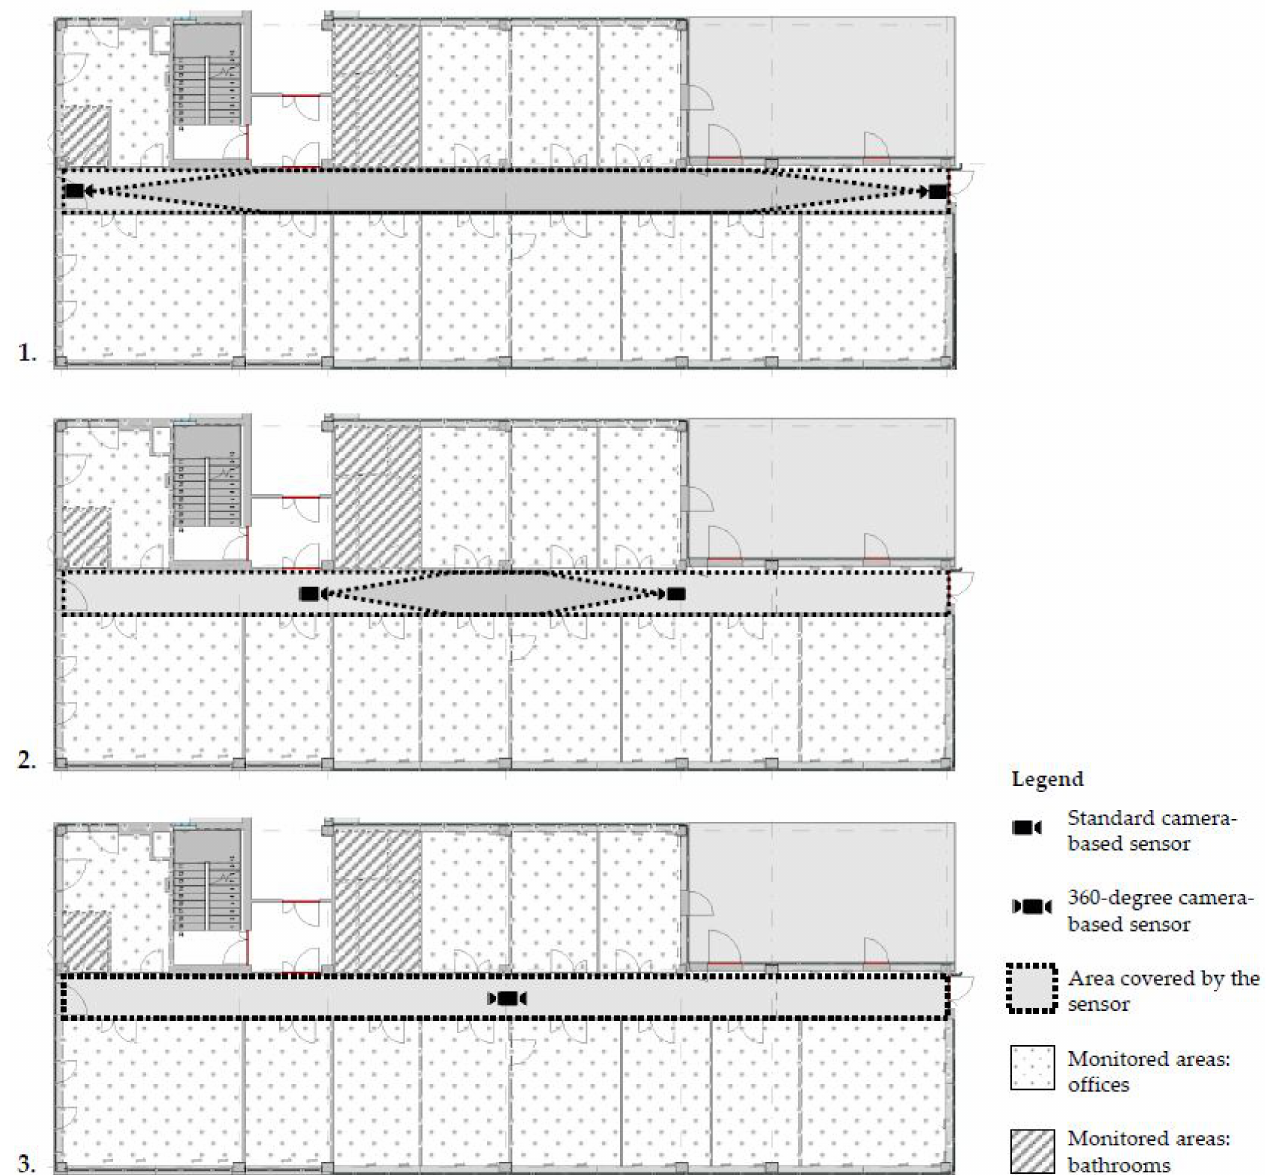
Figure 4. 2D visualization of the three simulations of sensors positioning in a typical corridor through the BIM model. The BIM model also allowed for an optimization of the field-of-view of the sensors, as shown in Figure 6. The virtual camera field-of-view simulation supported the definition of the best orientation, i.e., the best tilt angle of each camera on x- and y-axis. This ensured that all the offices and bathrooms defined as critical, whose occupancy needed to be monitored, were correctly detected by the